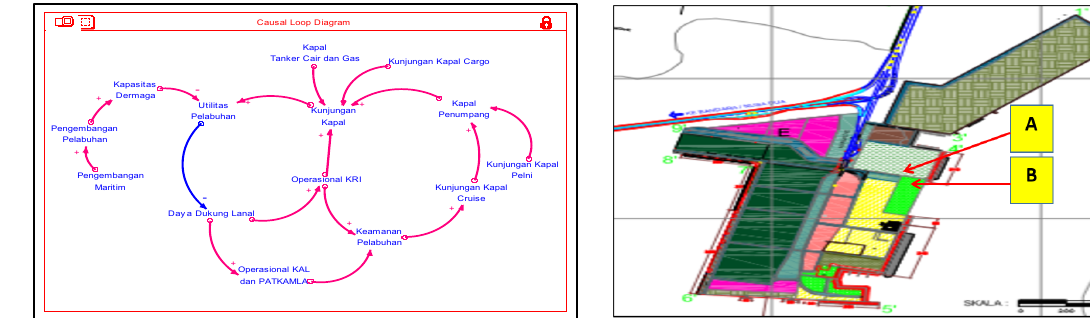
Fig. 4. Causal Loop Diagram of Research Fig. 5. Planned Allocation of Wharf Development in Short Term (2017-2022)